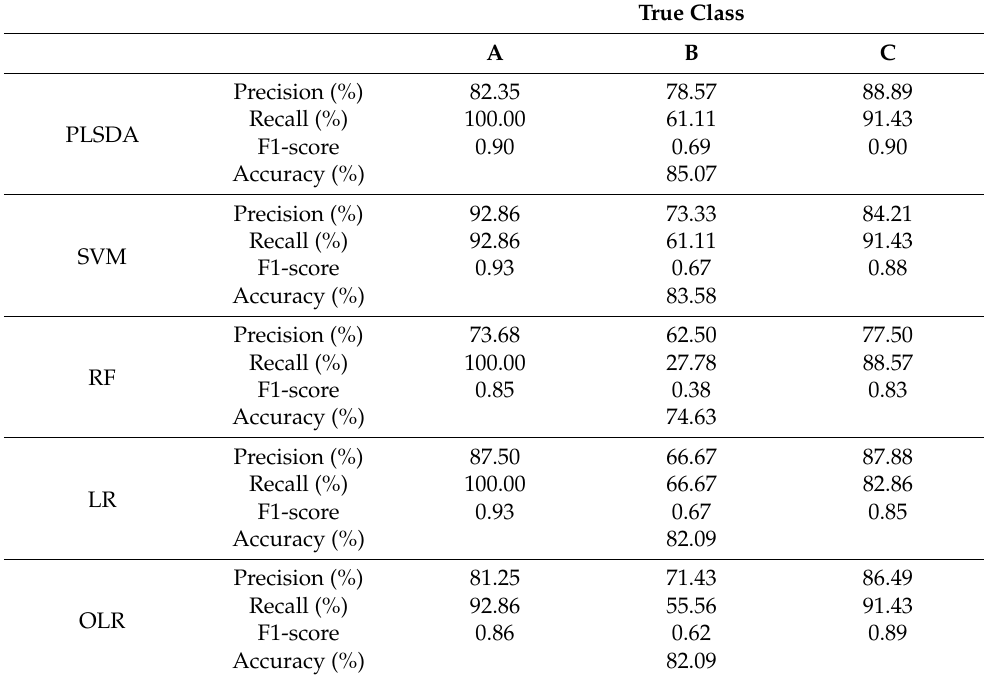
Table 2. Precision (%), recall (%), F1-score, and accuracy (%) for PLSDA, SVM, RF, LR, and OLR classification models for external validation (n = 67) of chicken burger samples using MSI data, considering three microbiological quality classes: A (satisfactory), B (acceptable), C